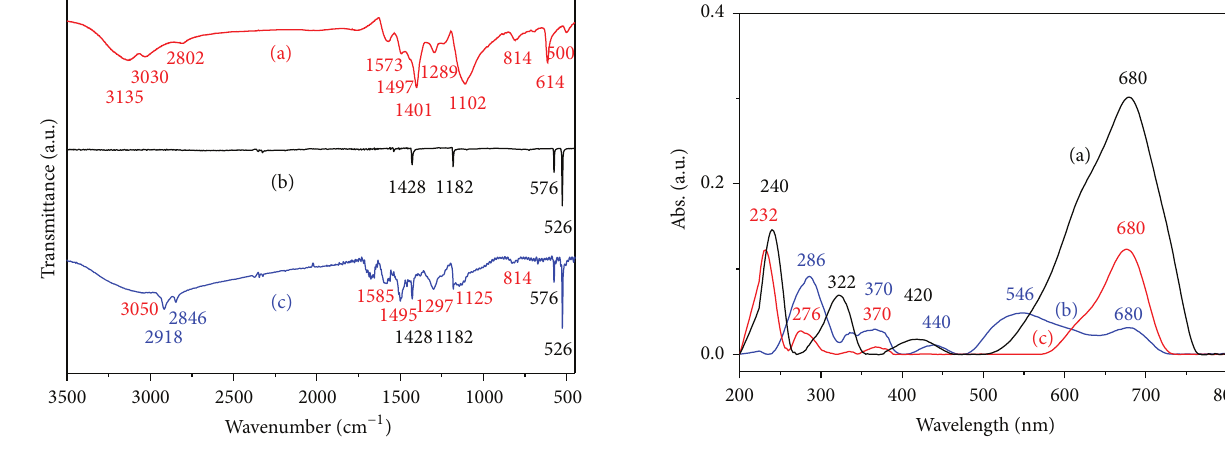
Figure 2: FT-IR spectra of (a) FWs, (b) PANI-EB powder, and (c) PANI-EB-doped FWs.